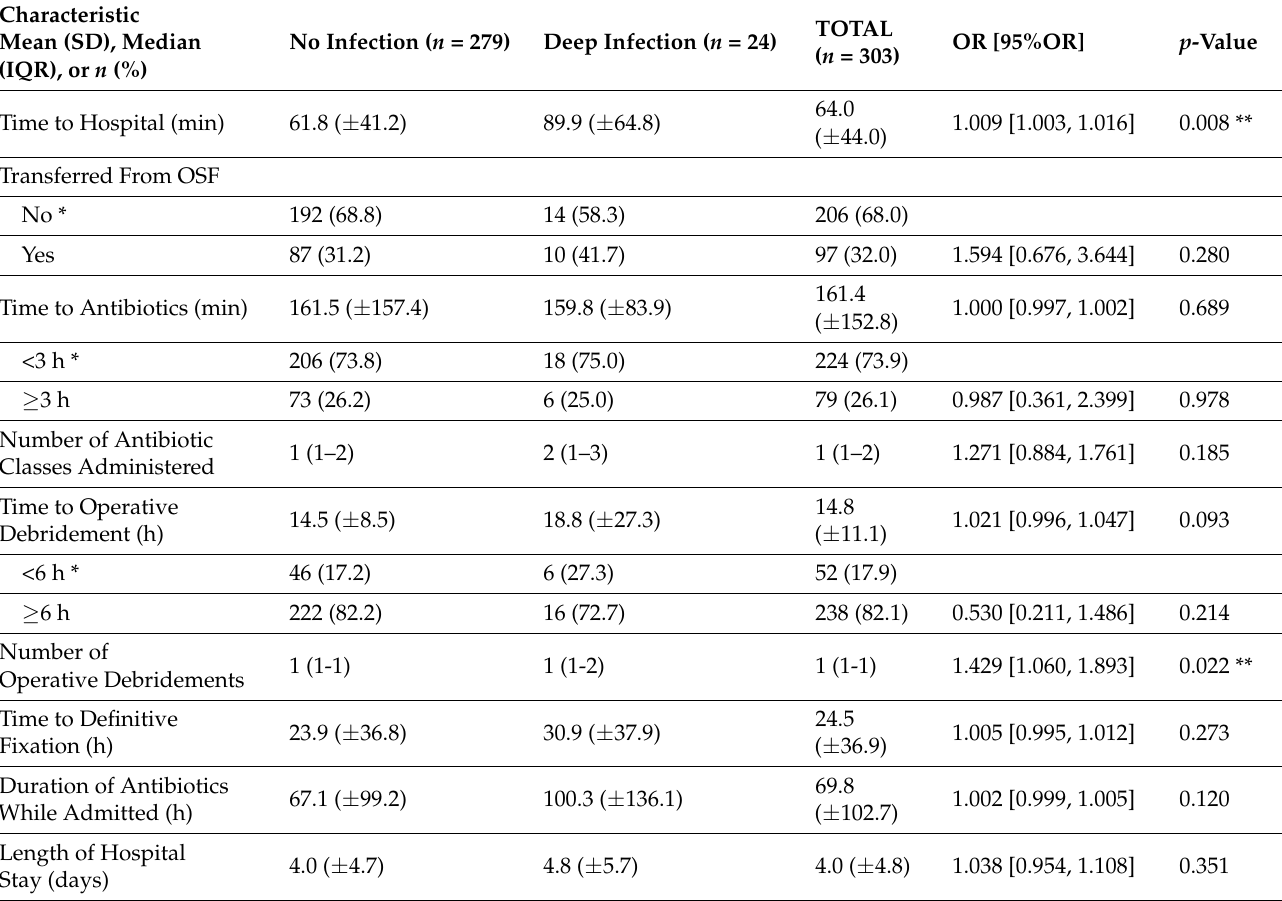
Table 4. Open Fracture Management